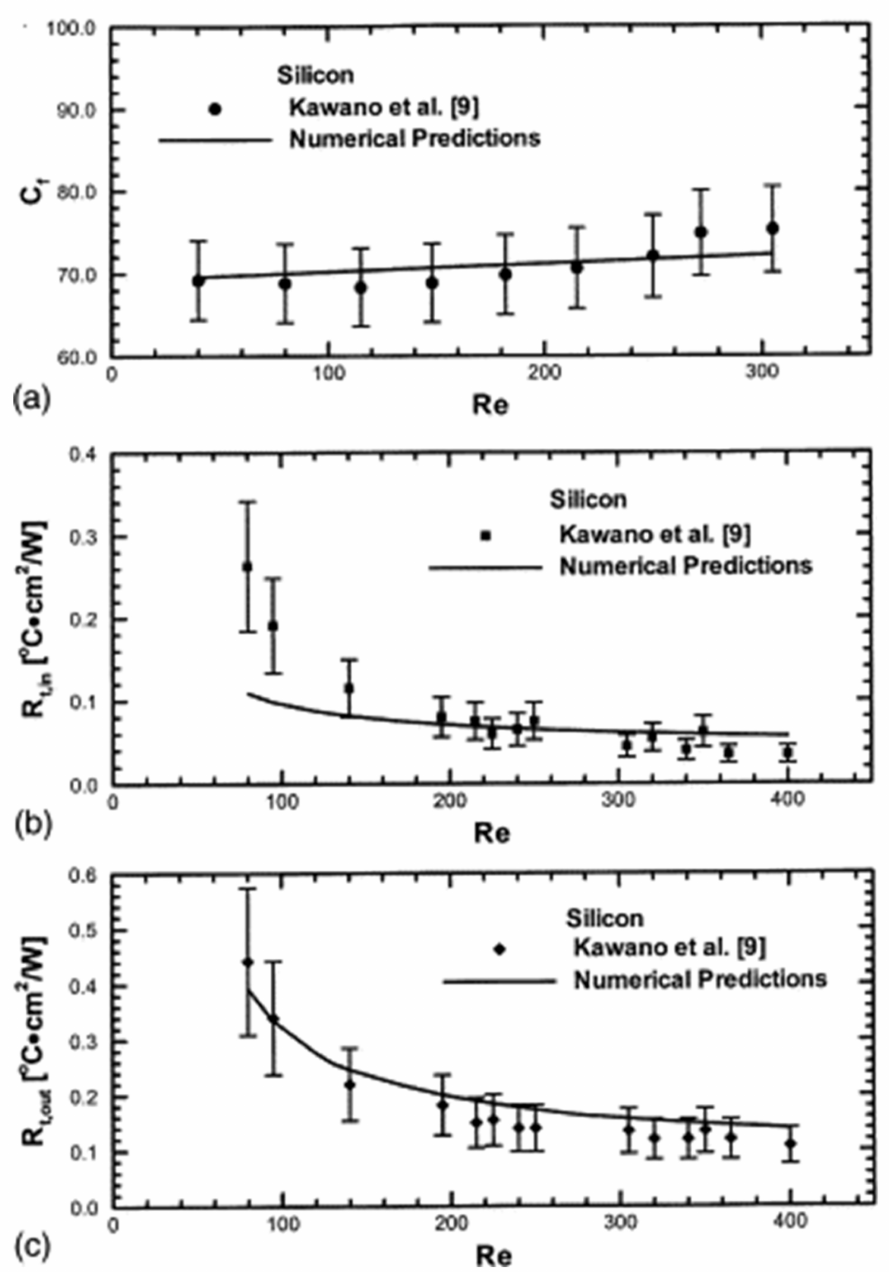
Figure 14. Validations between numerical findings of Qu and Mudawar [235] © Elsevier, 2002 and experiments of Kawano et al. [236] © Elsevier, 1998; ( a ) friction coefficient, ( b ) inlet thermal resistance, and ( c ) outlet thermal